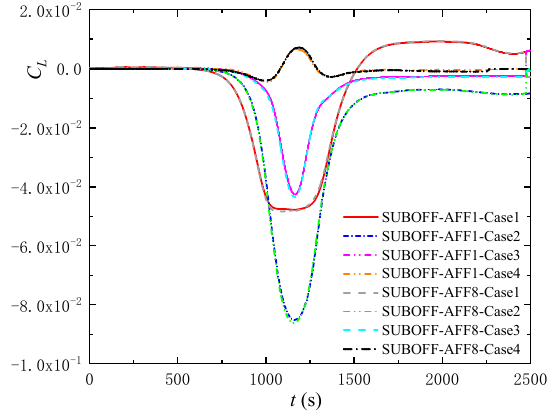
Figure 14. Time series of the nondimensional lift.